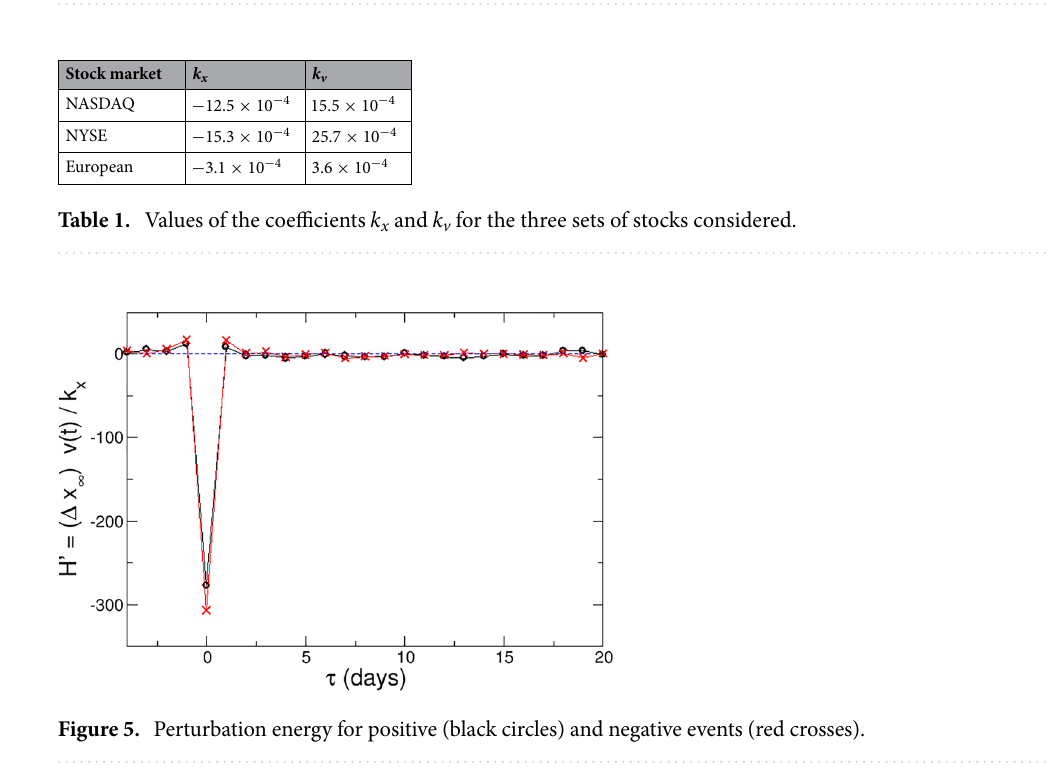
Figure 4. Mean log-return and volatility variations as a function of the total log-price variation for small events, as labelled. The solid red line indicates the prediction for the log-return.